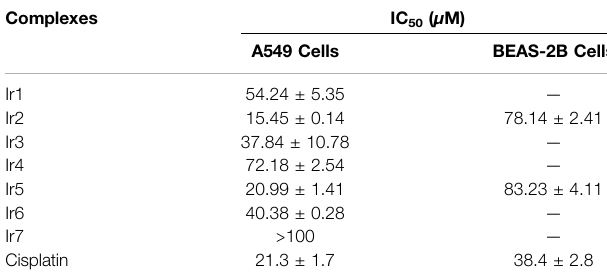
TABLE 1 | IC 50 ( μ M) values of the complexes toward selected cells for 24 h.